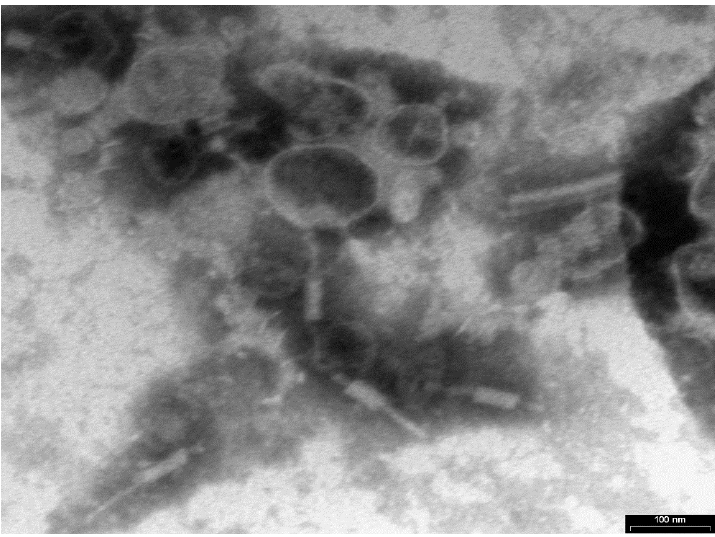
Figure 1. Phage Xccφ1 structure as observed by transmission electron microscopy (TEM). The scale bar represents 100 nm.